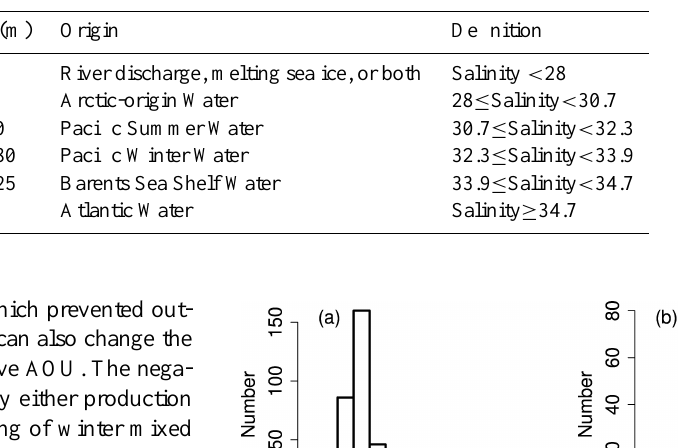
Table 1. Definition of water masses in this study.